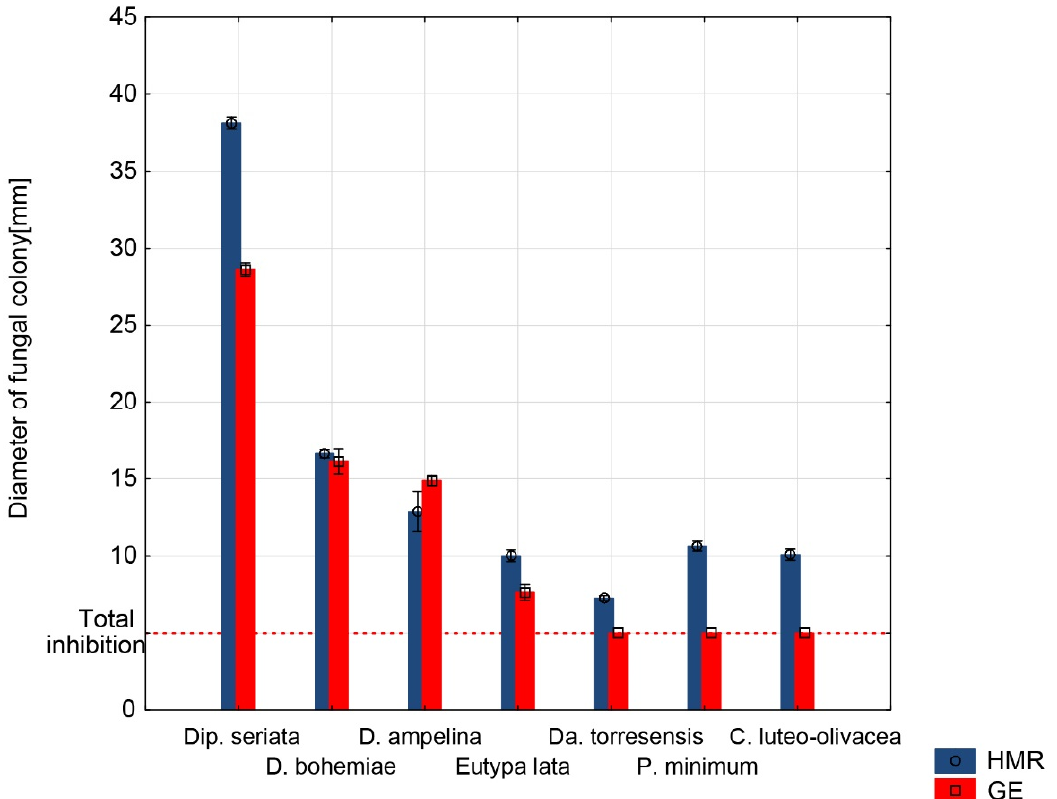
Figure 2. Comparison of antifungal effects of pure HMR TM and GE; plates of both variants contained 1 mg·mL − 1 HMR in the medium. Measurements were performed after 5 days of incubation for all fungi except P. minimum and C. luteo-olivacea, which were measured after 10 days. A colony diam.